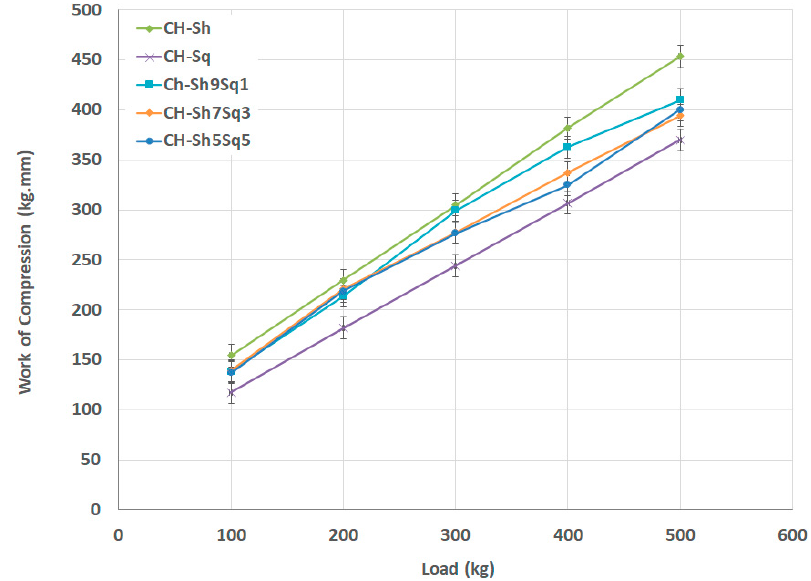
Figure 11. Compression work for CH-Sh9Sq1, CH-Sh7Sq3, and CH-Sh5Sq5 CH mixtures in comparison with pure CH-Sh and CH-Sq.